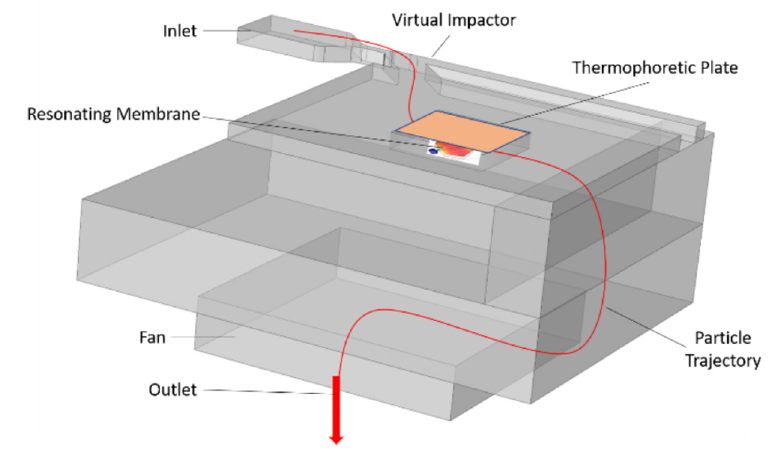
Figure 2. The complete solution for PM sensing (red line shows the trajectory of the particle inside the sensor).